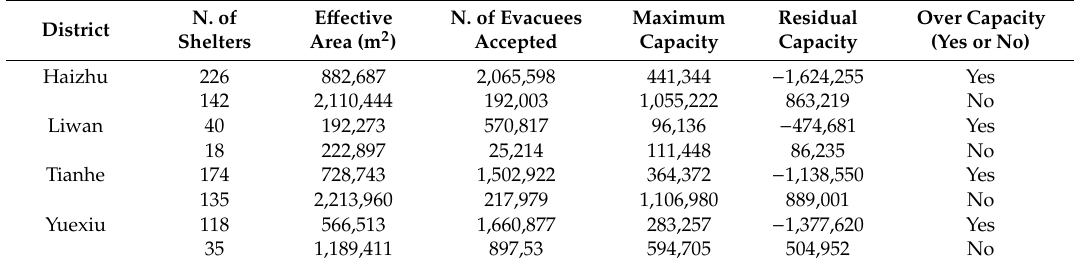
Table 7. The final state of shelter capacity in each district after the